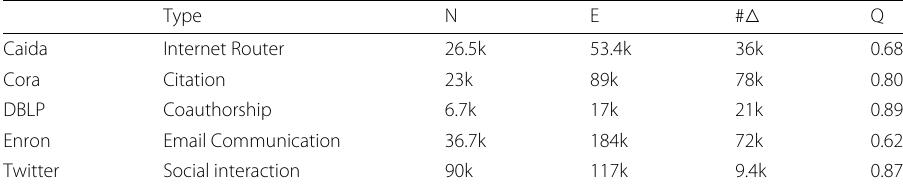
Table 1 Basic Characterization of Real